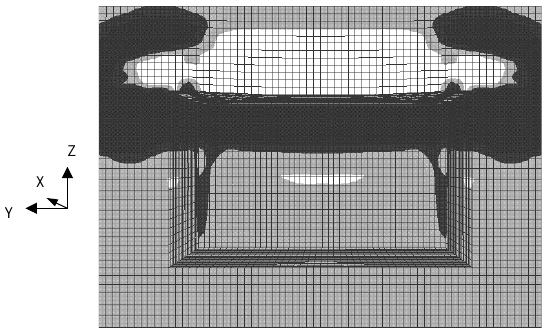
Fig. 5. An LS-TAURUS plot showing the propagation of the incident pressure wave (in the negative z-direction), through the fluid mesh approximately 90 µ s after the pressure wave (dark shade) has im- pinged on the plate surface (simulation #4). The simulation shows the local cavitation zone (white shade) extending over the entire re- gion of the test plate and approximately 25 cm in front of the plate. The rig structure mesh has been excluded from this